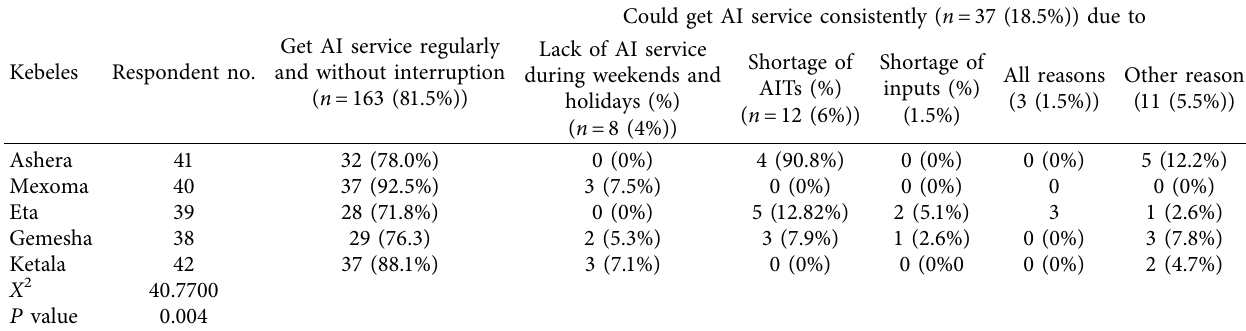
Table 1: AI service status in diferent Kacha Bira district kebeles.